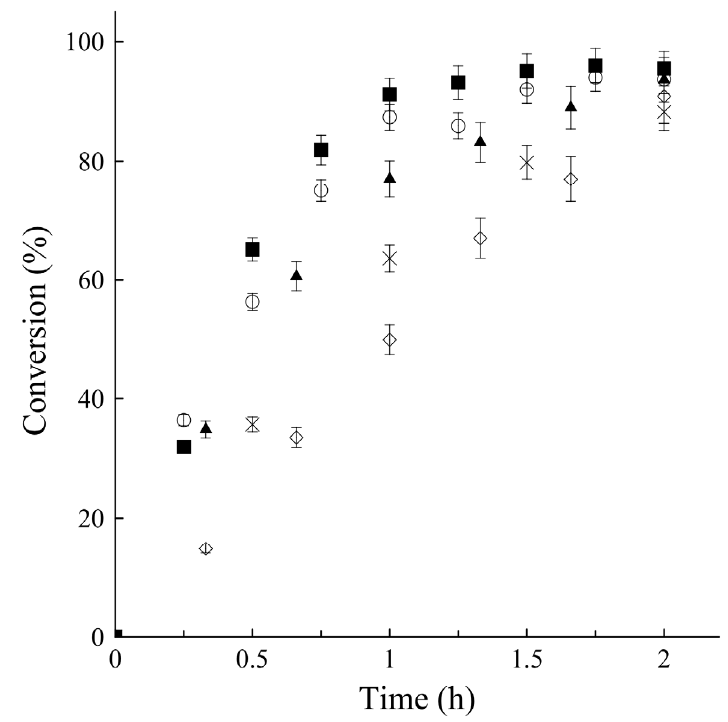
Figure 2. Time-course of butyl acetate synthesis at 0.3 M acetic acid: (  ) MCI-CALB under optimal condition I; (  ) MCI-CALB under Condition II; (  ) MCI-CALB under mechanical stirring conditions; (  ) Novozym 435 under ultrasound conditions; (  ) Novozym 435 mechanical stirring